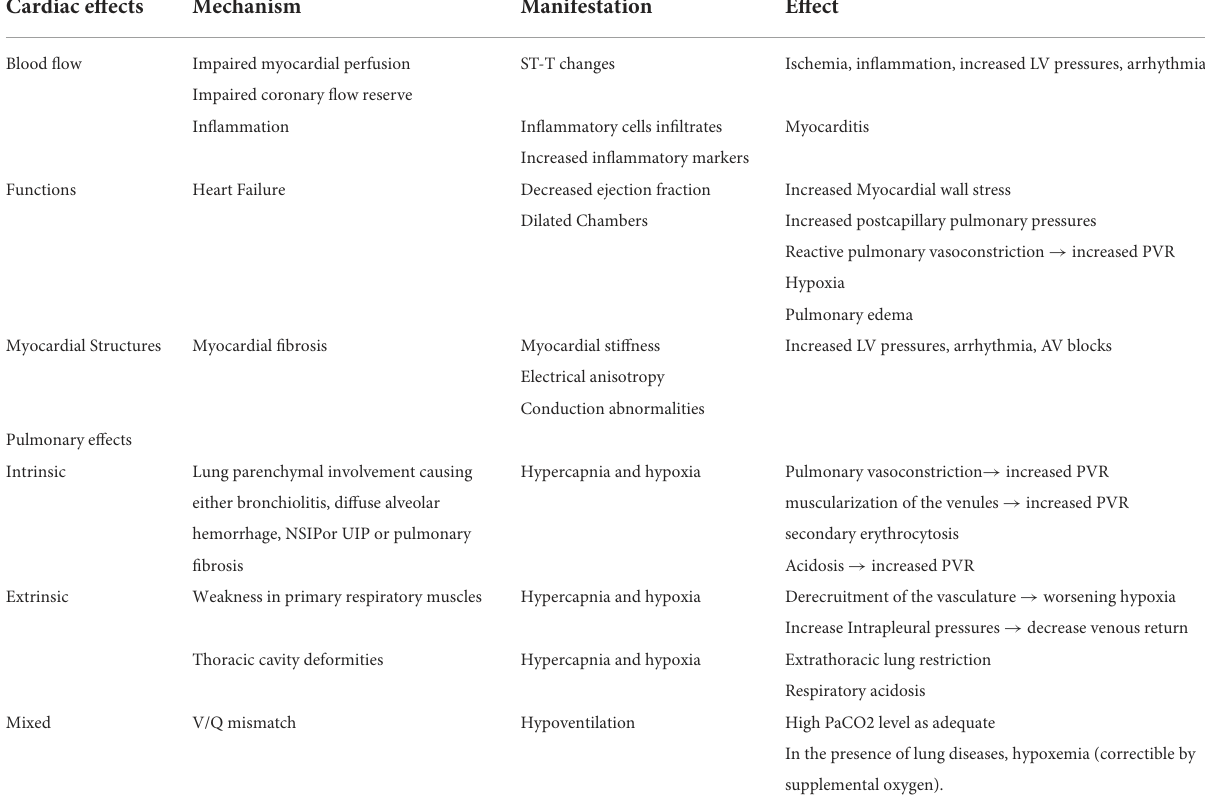
TABLE 2 Cardiac and pulmonary pathophysiological mechanisms in